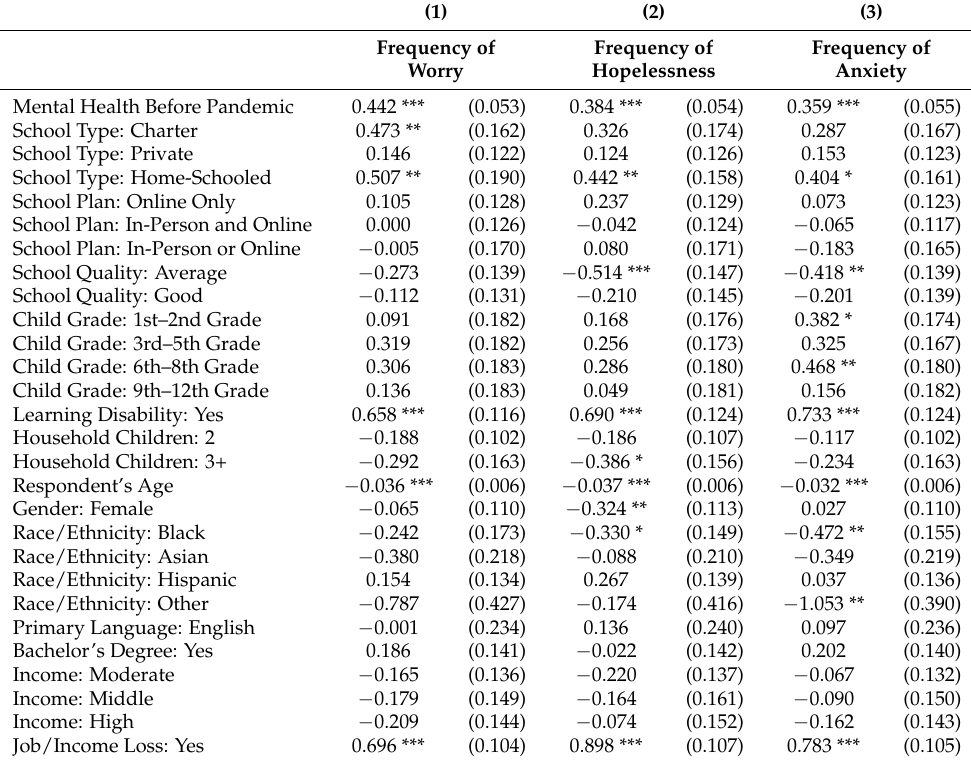
Table 3. Worry, hopelessness, and anxiety during COVID-19 (ordered logistic multivariate regres- sion